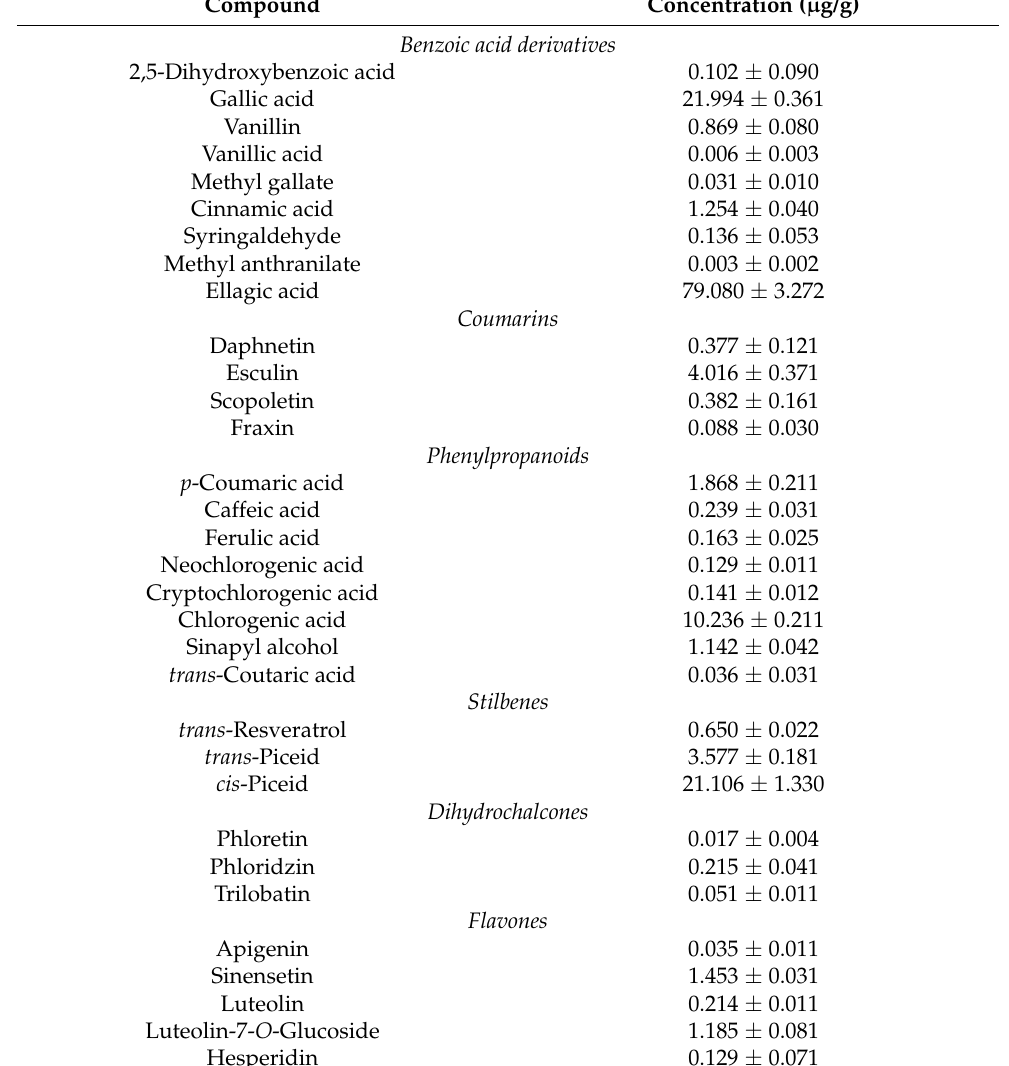
Table 1. Quantification of metabolites from tapereb á peel ( µ g/g) by